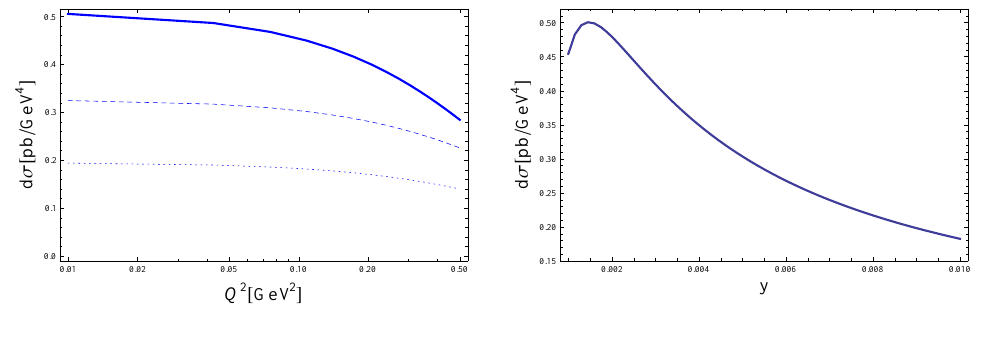
) d σ ( e − N → ν ND − s (in pb d y dQ 2 dt = 0 and s = 20000 T